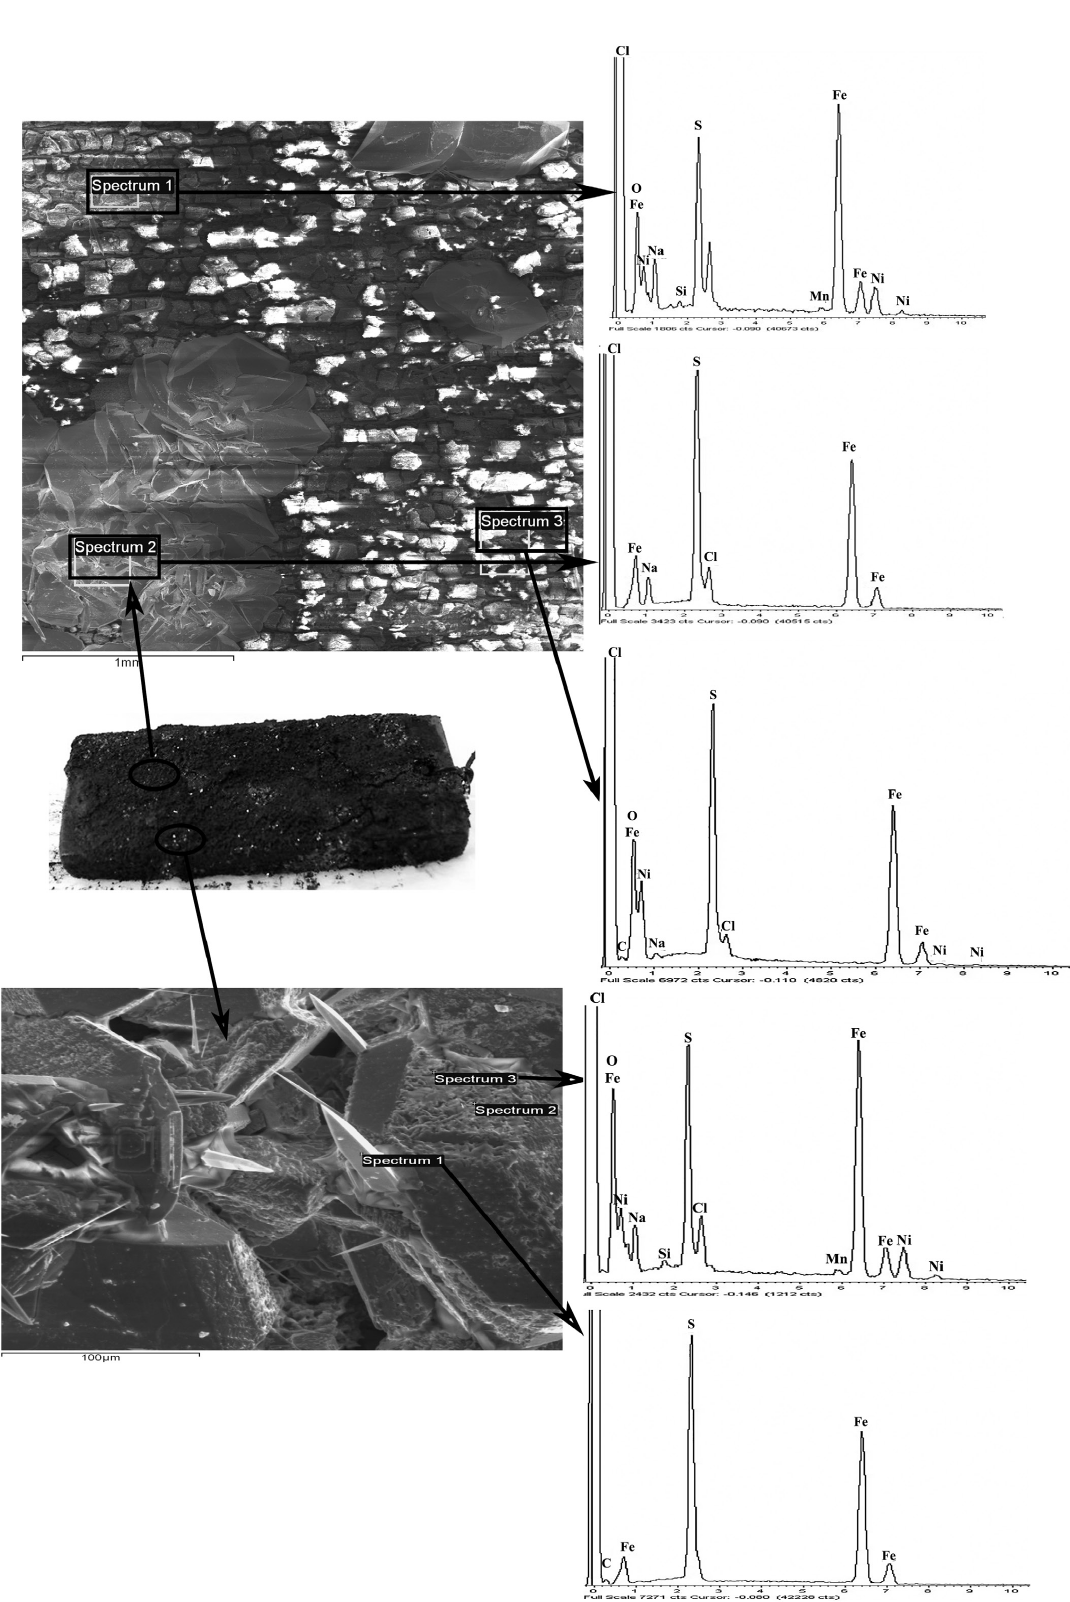
Figure 7. SEM and EDS characterization of the corrosion product film on the surface of the welded joint tested in solution 2,